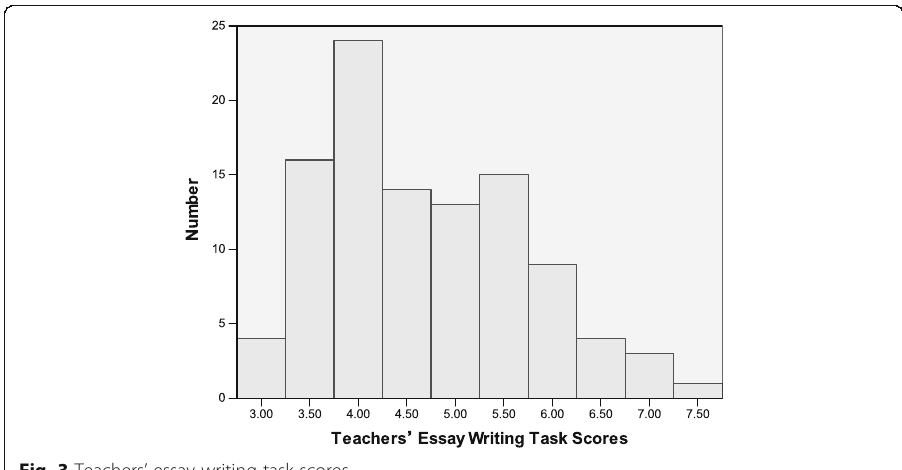
Fig. 3 Teachers ’ essay writing task scores